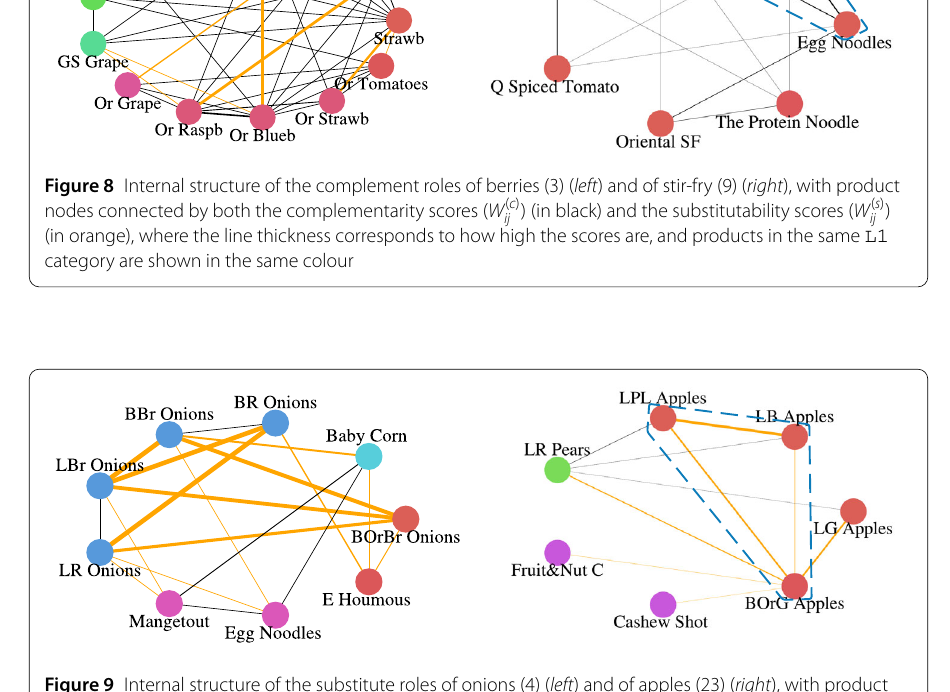
egg noodles form a triangle in the complement role of stir-fry (9); see the blue polygon in Fig. 8. Strong substitutes are expected to form complete graphs in the substitute unipartite net- work W ( s ) , and our results are largely consistent with the expectation. For example, loose Braeburn apples (LB Apples), loose Pink Lady apples (LPL Apples), and bagged organic Gala apples (BOrG Apples) constitute a triangle in the substitute role of apples (23); see the blue polygon in Fig. 9. Note this expectation is only valid if the substitutes are con- sumed for the same purpose; if this assumption is violated, seemingly substitute products may end up being complements. For example, loose brown onions (LBr Onions) and loose red onions (LR Onions) in the substitute role of onions (4) are both substitutes of products such as bagged red onions (BR Onions) and bagged organic brown onions (BOrBr Onions), but are complements of each other; see Fig. 9. The difference between their quantities and their common substitutes may be the key factor here. Likewise, even with the common substitute bagged organic Gala apples (BOrG Apples), loose ripe pears (LR Pears) is a complement of loose Pink Lady apples (LPL Apples), loose Braeburn apples (LB Apples) and loose Gala apples (LG Apples). The above observations confirms the complexity of the interaction between complements and